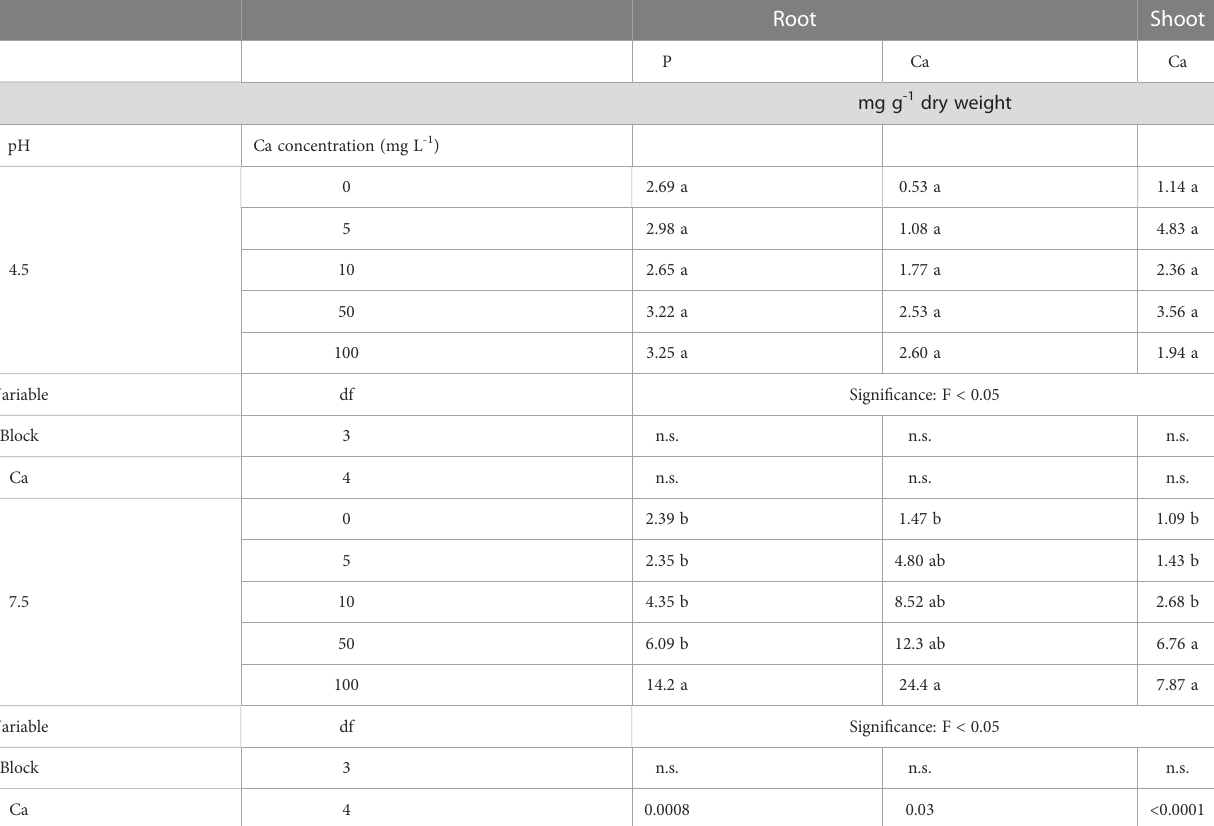
TABLE 3 The interactive effect of pH (4.5 and 7.5) and Ca concentration (0, 5, 10, 50 and 100 mg L -1 ) on the concentrations of selected elements in the root and shoot of Southern highbush blueberry ( Vaccinium corymbosum , cv. Windsor) plants after 12 weeks of growth in nutrient